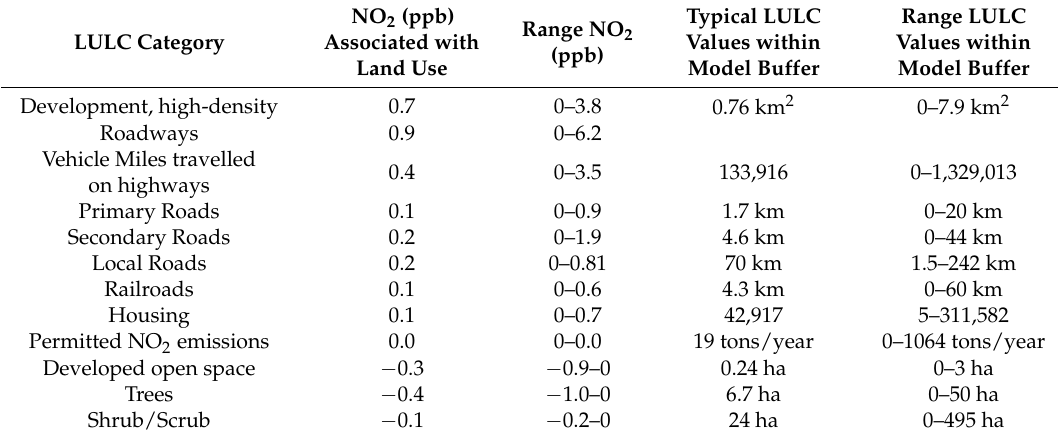
Table 3. Estimated association of land use and annual average NO 2 concentrations, averaged over the study area, as well as average land use values within the model buffers.